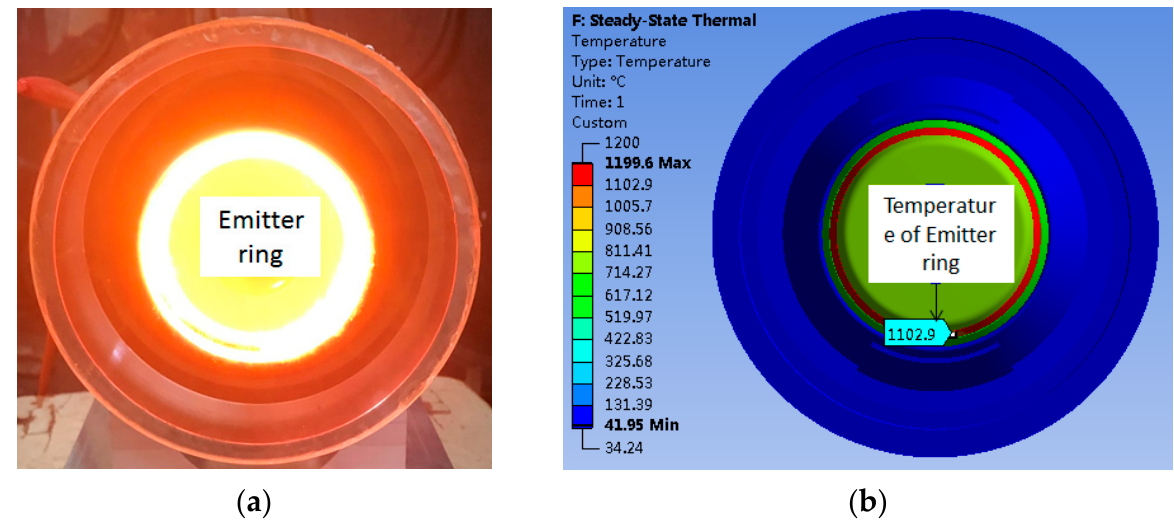
Figure 8. Temperature experience and simulation: ( a ) the temperature of the emitter ring (highlight circle) was approximately 1048 °C during testing; ( b ) the temperature of the emitter ring was ap- proximately 1100 °C according to the simulation.